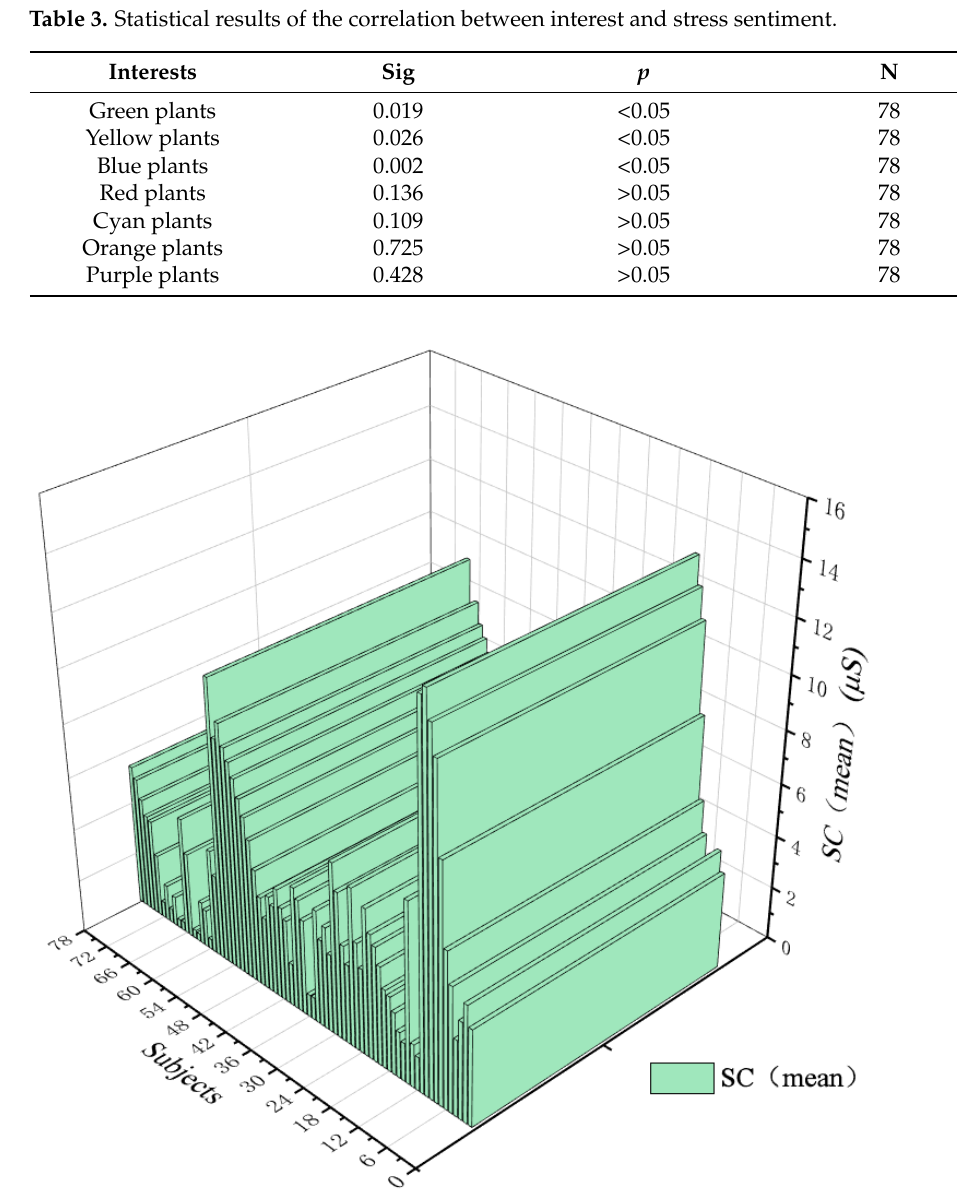
Figure 9. Trend chart of subjects’ SC average wave value change. Source: The ErgoLAB platform exports data, and the maximum SC average wave value is 14.27 μ S, the minimum value is 0.29 μ S, and the average value is 4.32 μ S.